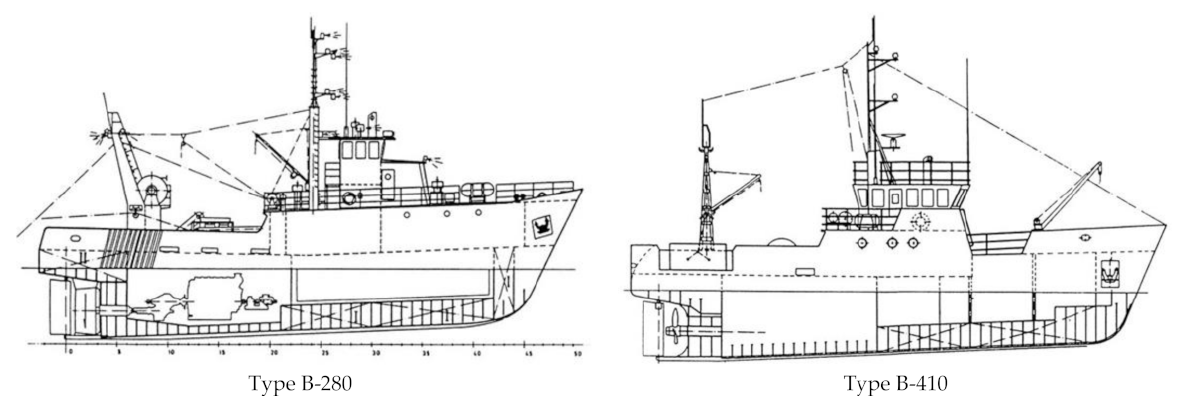
Figure 2. Side views of typical Polish medium-sized fishing vessels, more information on technical details of the vessels can be found in